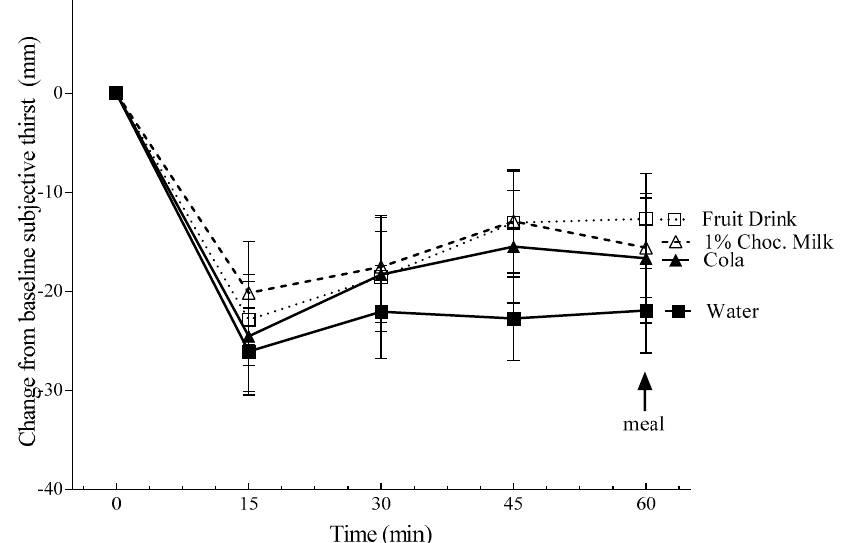
Figure 2. The change from the baseline subjective thirst over 60 min. The values are mean ± SEM ( n = 32). The change from the baseline scores was affected by the treatment ( p = 0.027) and time ( p = 0.014). Subjective thirst was significantly lower after water compared with the fruit drink ( p = 0.048) and 1% chocolate milk ( p =